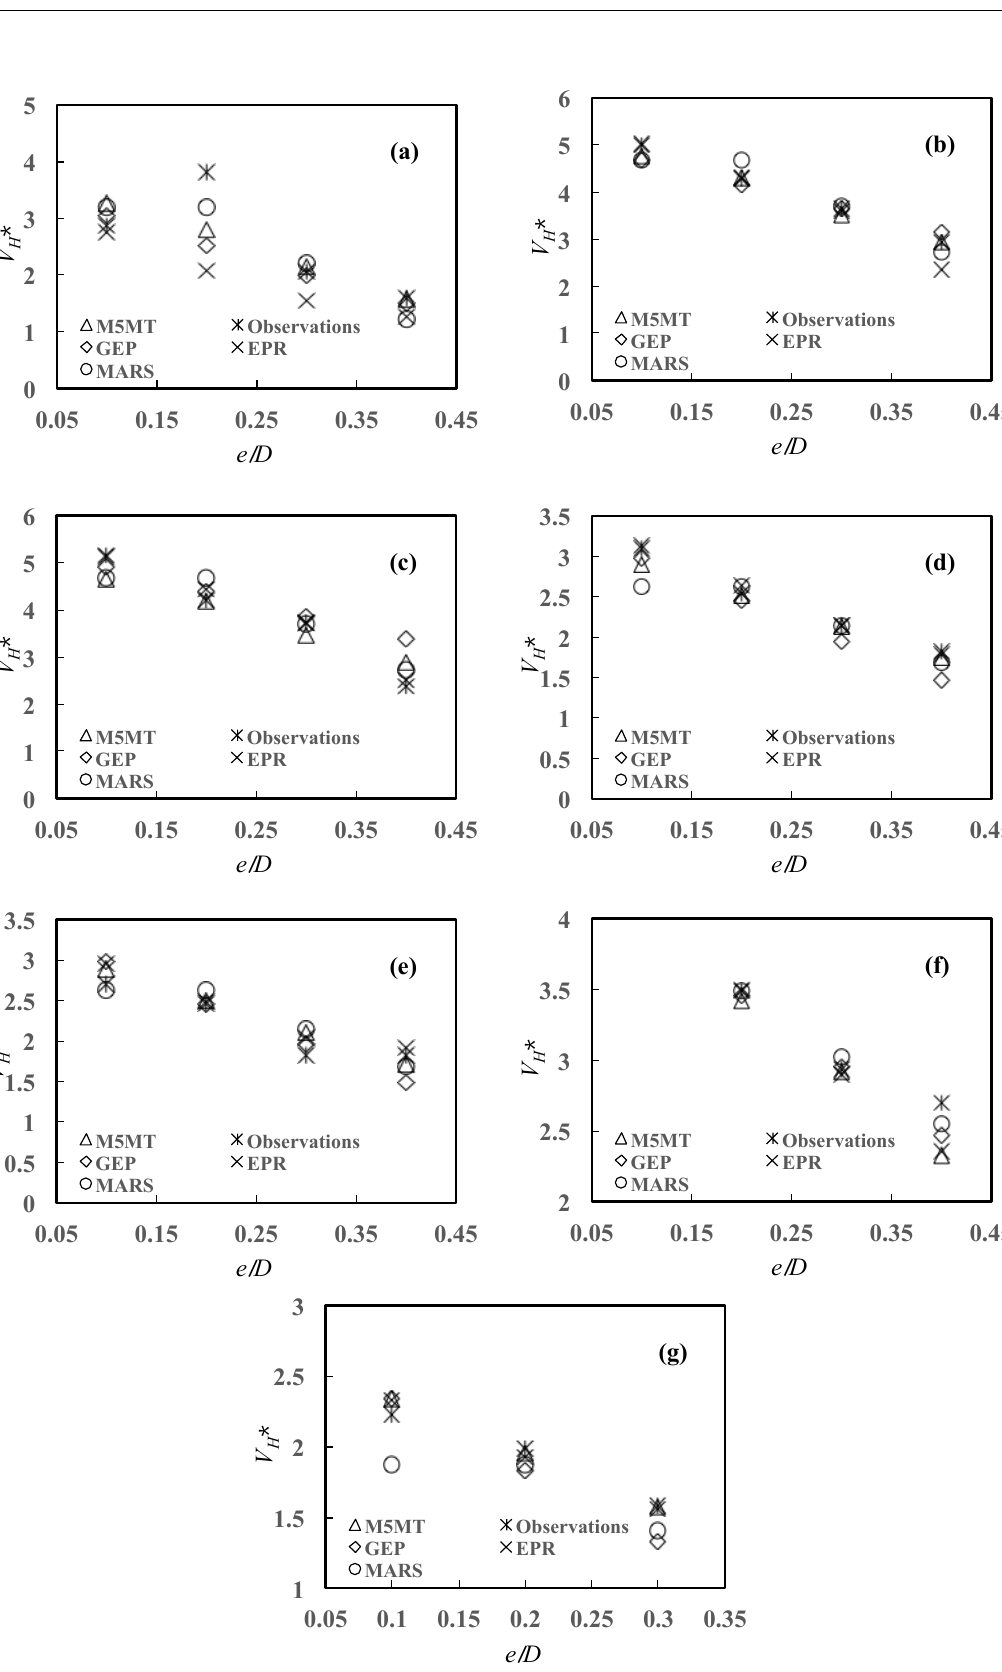
Figure 8a shows that the experimental values of 𝑉 𝐻 ∗ , for KC = 8.7 and α = 0° increase from 2.77 at e / D = 0.1 to 3.81 at e / D = 0.2 and then descend towards 1.51 at e / D = 0.4. This non-monotonic trend is well captured by the MARS model, the results of which are more in harmony with the observations in comparison to the remaining models. All the AI mod- els show underprediction at e / D = 0.2. Quantitatively, the EPR model exhibits significant